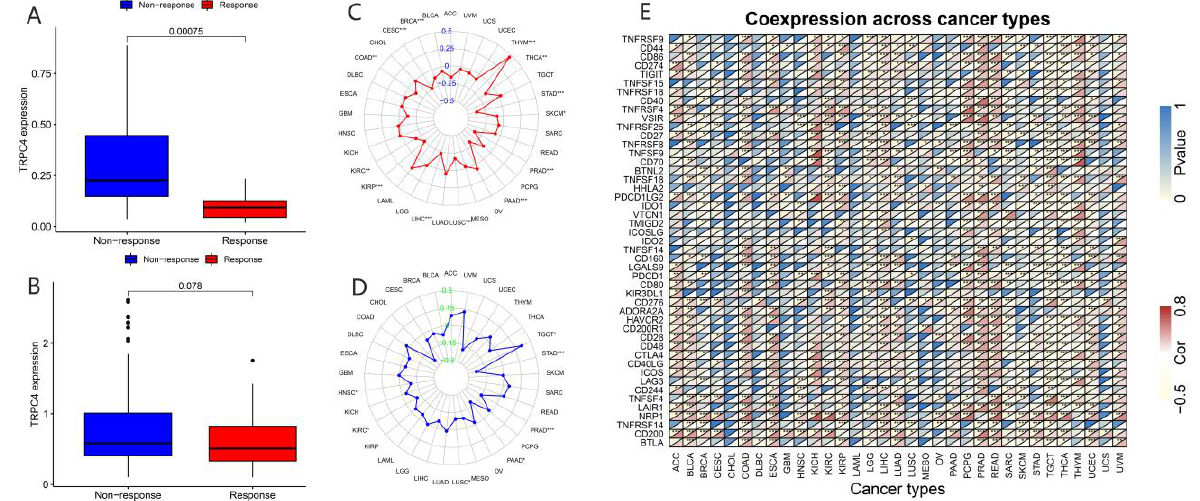
Figure 9. Correlation of immunotherapy outcome, TMB, MSI, and immune-activation-related genes with the expressions of TRPV4. p < 0.05; ** p < 0.01; *** p < 0.001.